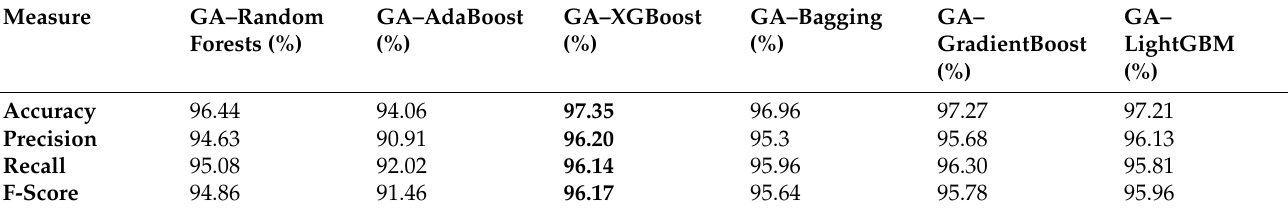
Table 10. Performance of GA-based ensemble classifiers for Dataset